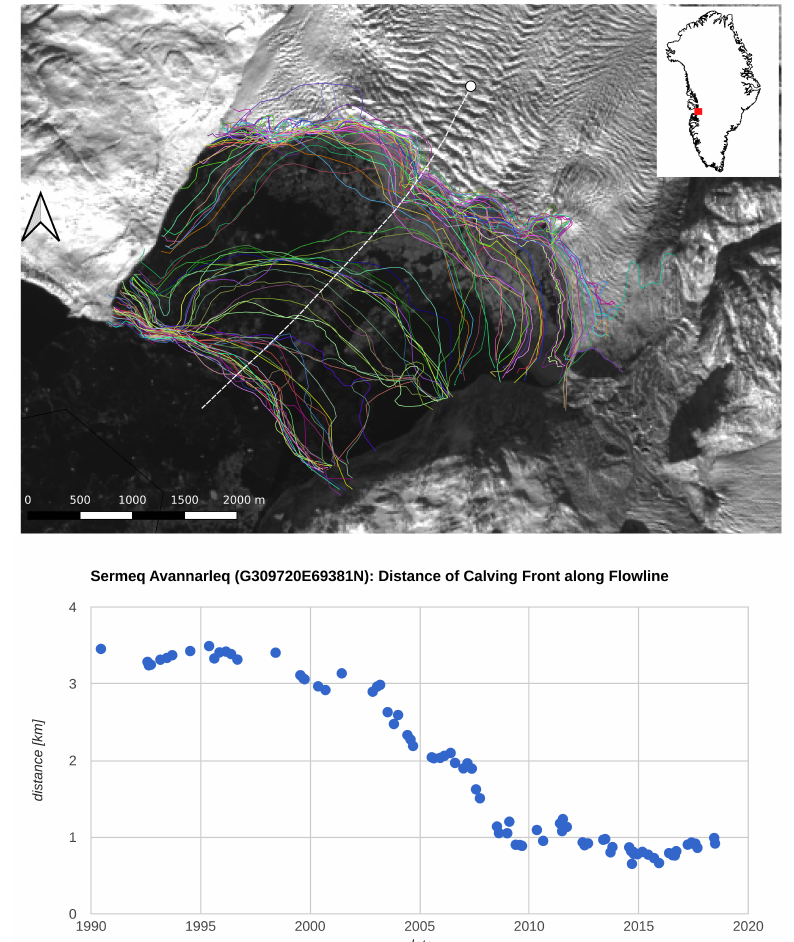
Figure 2. ( Top ) CFLs of Sermeq Avannarleq Glacier in West Greenland from 1990 to 2018 shown as coloured lines (background: Landsat-8 image acquired at 7 October 2014, USGS). ( Bottom ) temporal evolution of CFL plotted as distance along the central flowline (dashed white line in left